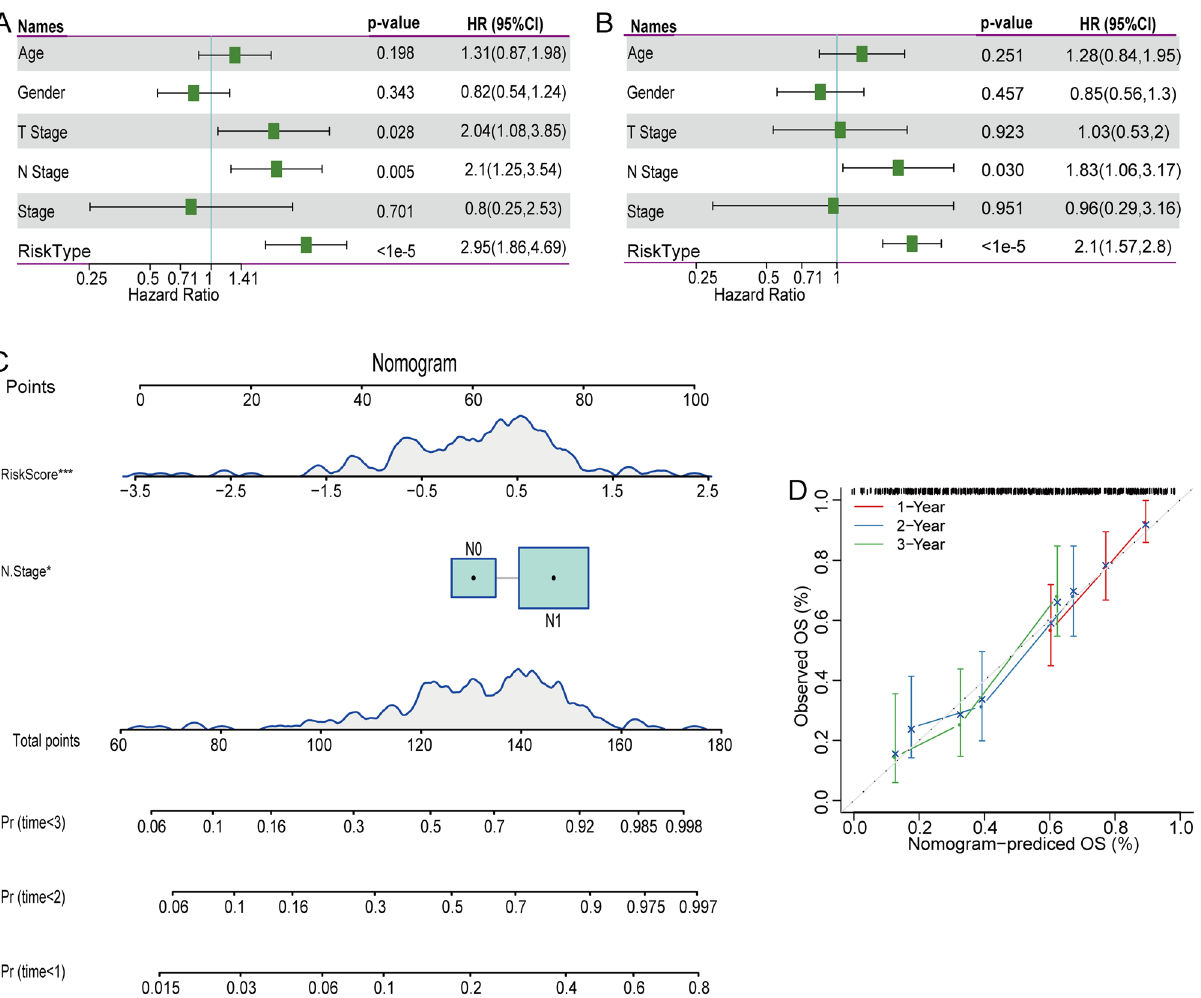
Figure 8. The risk score is an independent risk factor for the prognosis of pancreatic cancer. ( A – B ). Univariate and multivariate Cox regression analyses in the TCGA-PACA cohort. ( C ) Nomogram constructed by the risk score and clinical characteristics. ( D ) Calibration curve of the survival rate of the